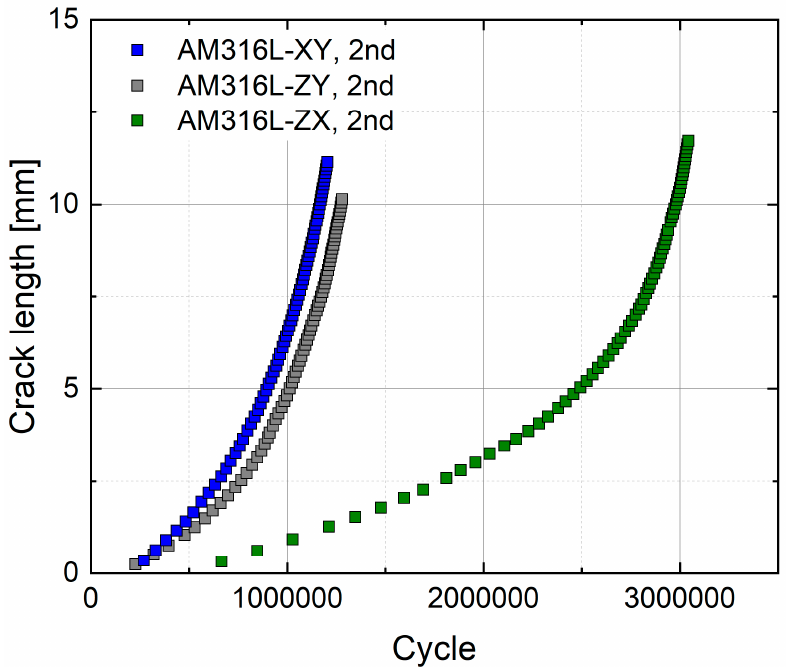
Figure 15. Crack length based on number of loading cycles of additively manufactured material with regard to build direction.